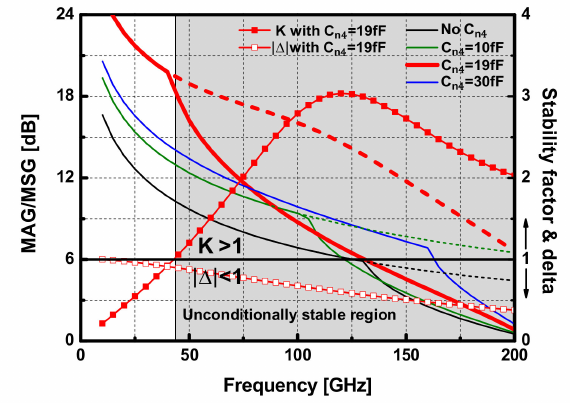
Figure 2. Simulated MSG (dashed lines)/MAG (solid lines) of the power stage differential pair depending on the neutralization capacitor C n4 and K and | ∆ | with C n4 = 19